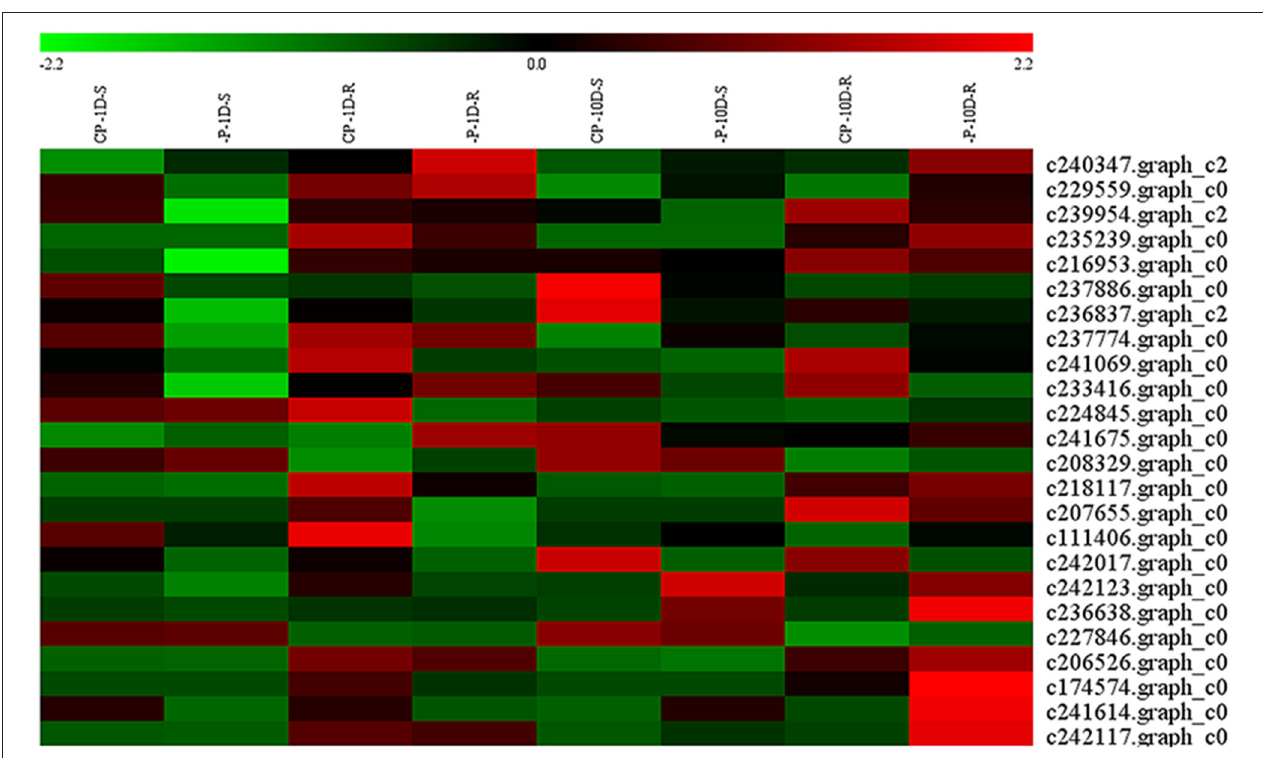
FIGURE 7 | Heatmap of the DEGs encoding RNases. Expression, represented by Z scores, is shown for selected DEGs due to -P conditions. Red indicates high expression, black indicates intermediate expression, and green indicates low